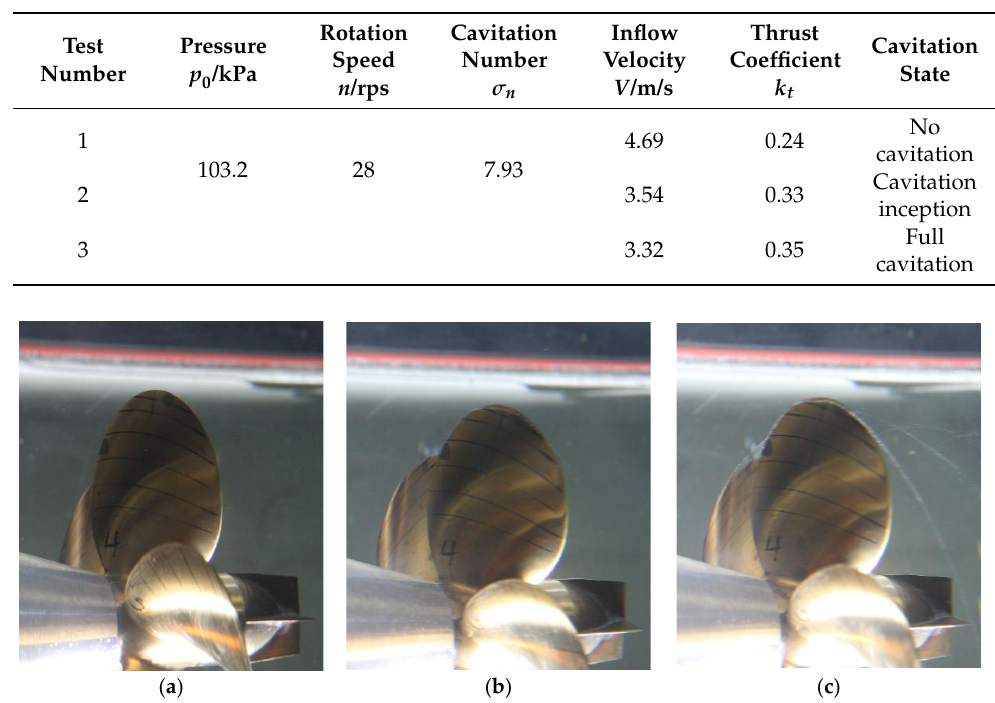
Table 4. Test condition and cavitation state of the propeller model.